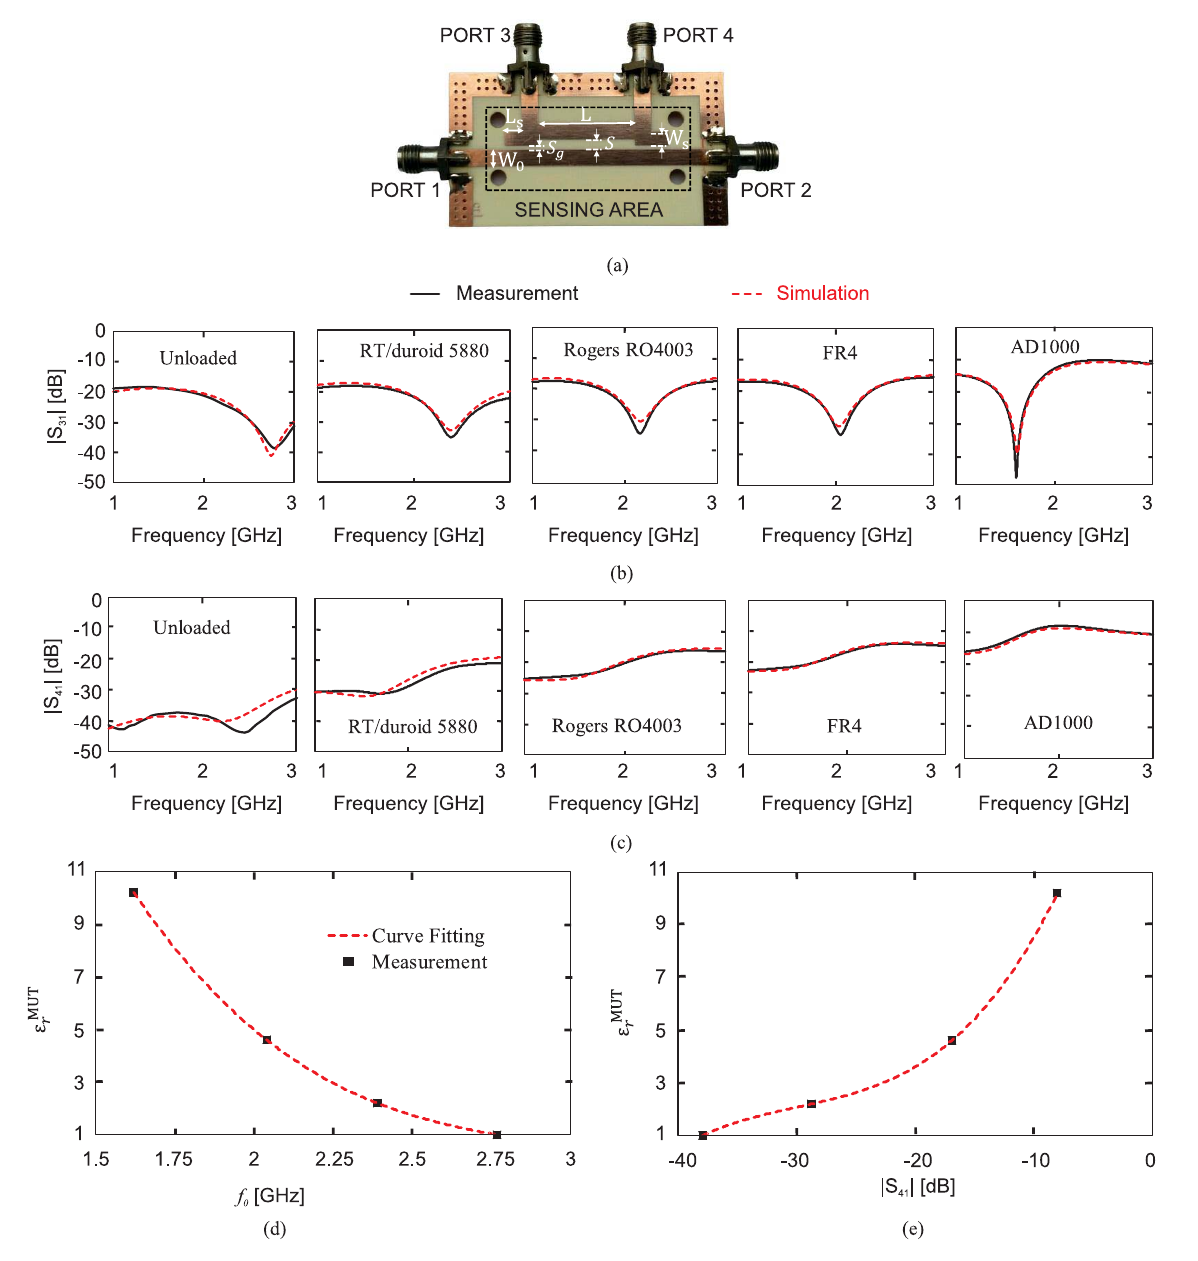
Figure 37. Simulation and measurement result comparison of the fabricated sensor. ( a ) Fabricated high-directivity microstrip coupled-line coupler. Simulated and measured ( b ) | S 31 | and ( c ) | S 41 | . Dielectric constant of the MUT as a function of the ( d ) zero-coupling frequency ( f 0 ) and ( e ) | S 41 | at 2 GHz. Reprinted with permission from Ref.